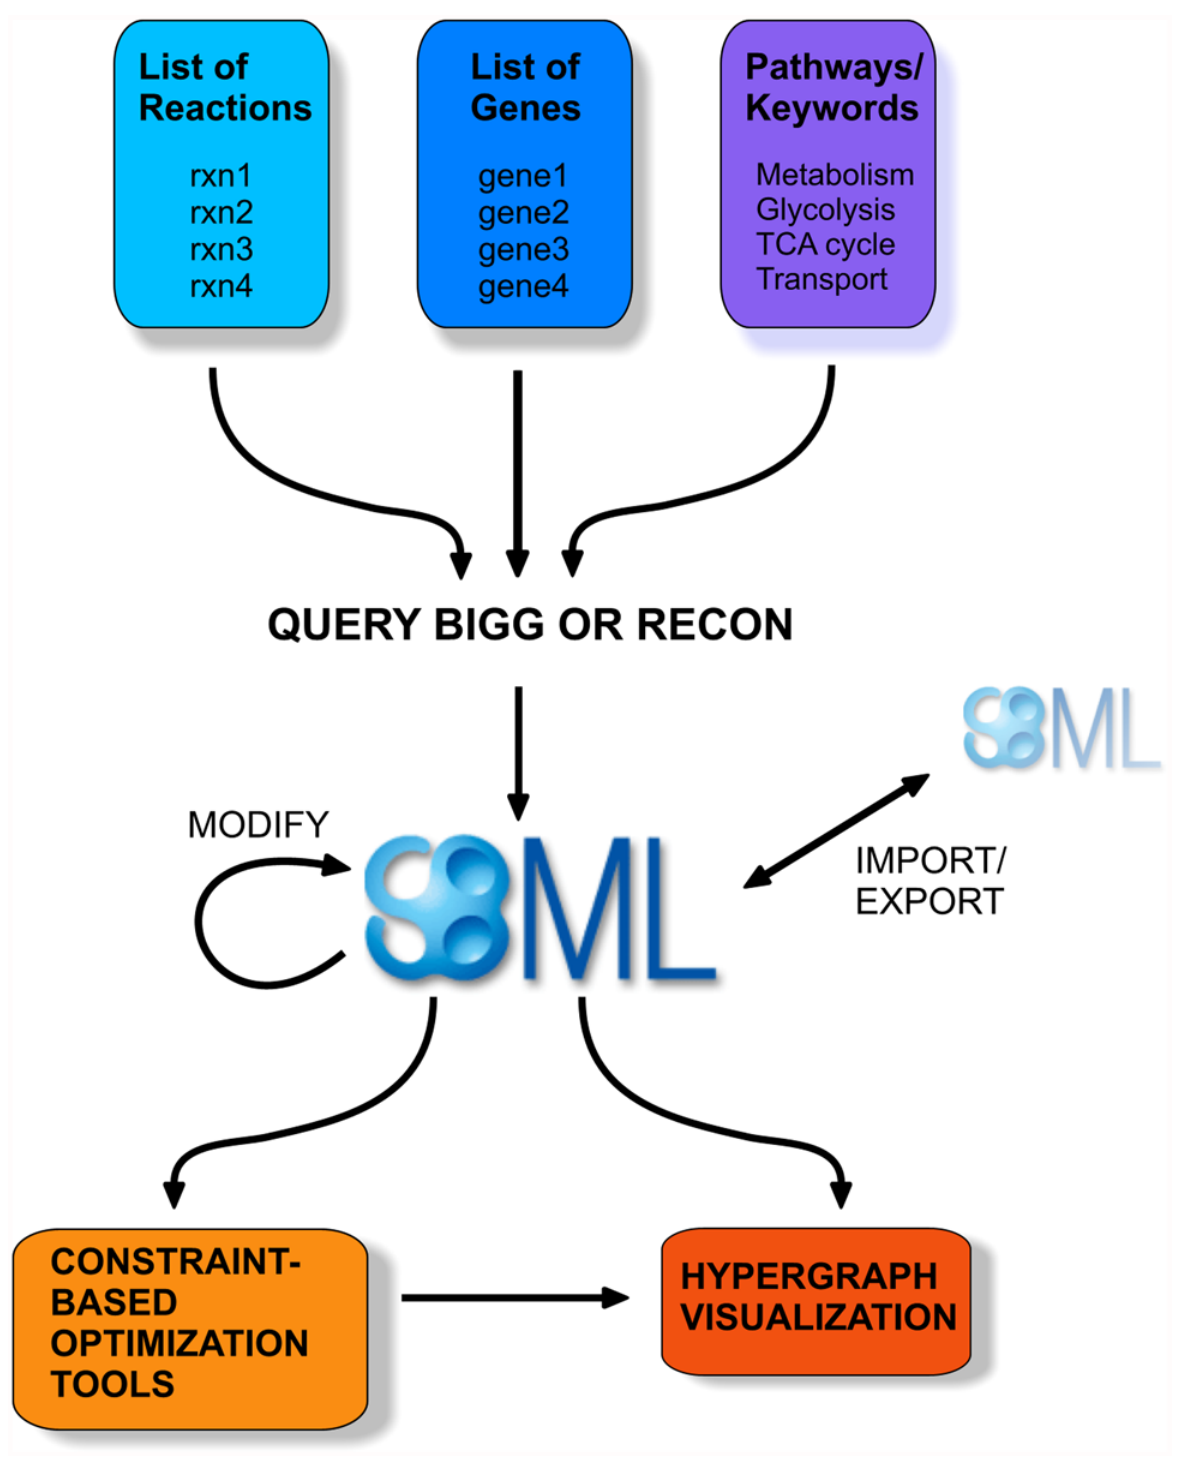
Fig 1. Overview of BiGGR functionality.